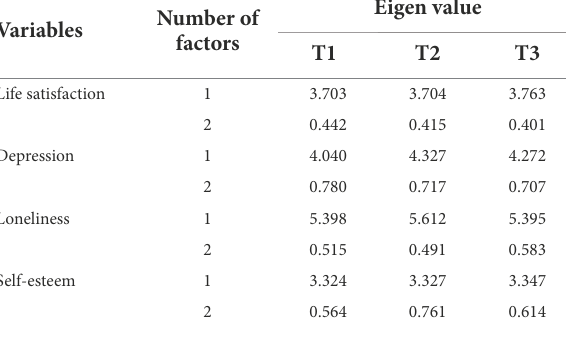
TABLE 1 Number of components and Eigen value of independent